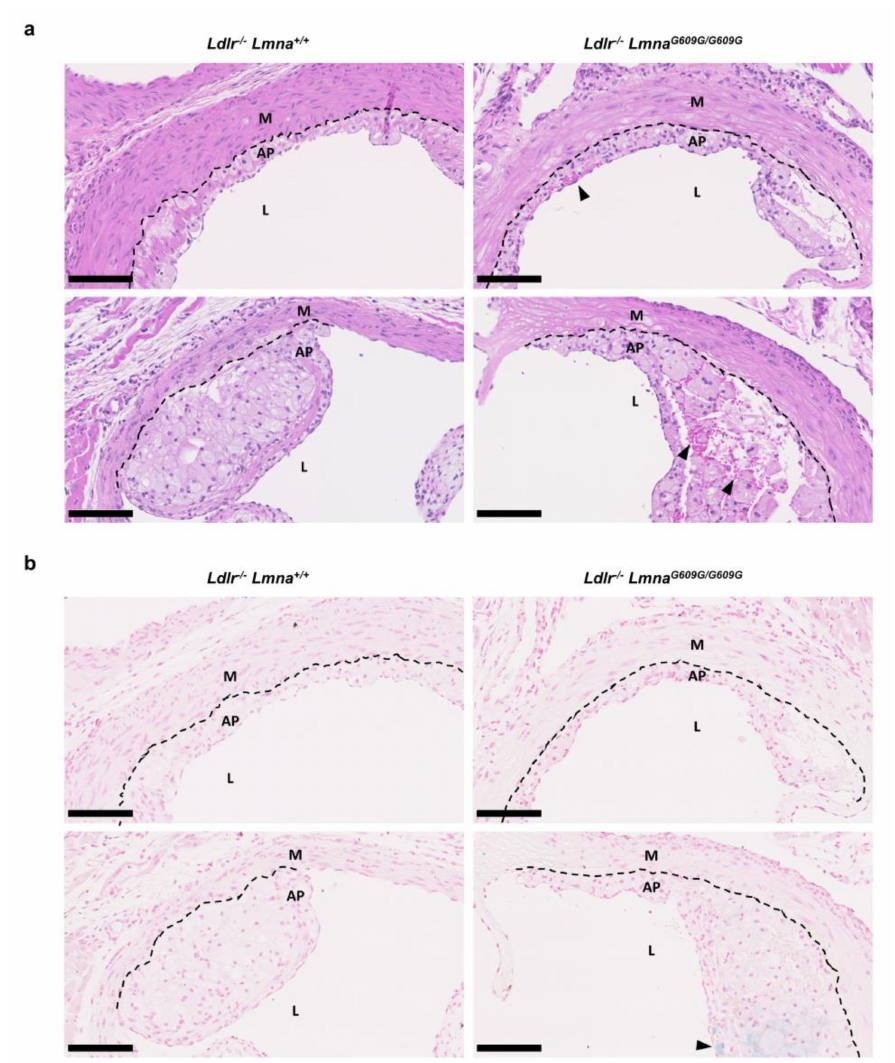
Figure 4. Presence of erythrocytes and iron deposits in atheromas of fat-fed male Ldlr − / − Lmna G609G / G609G mice. Male mice were fed a high-fat diet from eight weeks of age and sacrificed at 16 weeks of age. ( a ) Representative images of aortic root sections of Ldlr − / − Lmna +/+ and Ldlr − / − Lmna G609G / G609G mice stained with hematoxylin–eosin. Black arrowheads indicate erythrocytes. Scale bar, 100 µ m. ( b ) Representative images of aortic root sections of Ldlr − / − Lmna +/+ and Ldlr − / − Lmna G609G / G609G mice stained with Perls Prussian blue. Black arrowheads indicate iron deposits. Scale bar, 100 µ m. Discontinuous black lines mark the separation between the media and atheroma plaques. AP, atheroma plaque; M, media; L,